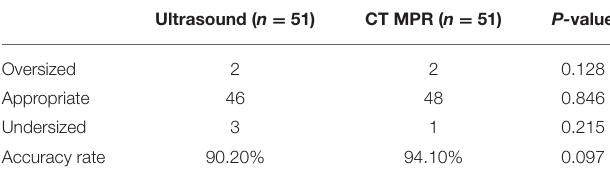
TABLE 5 | Comparison of LDLT accuracy between the two